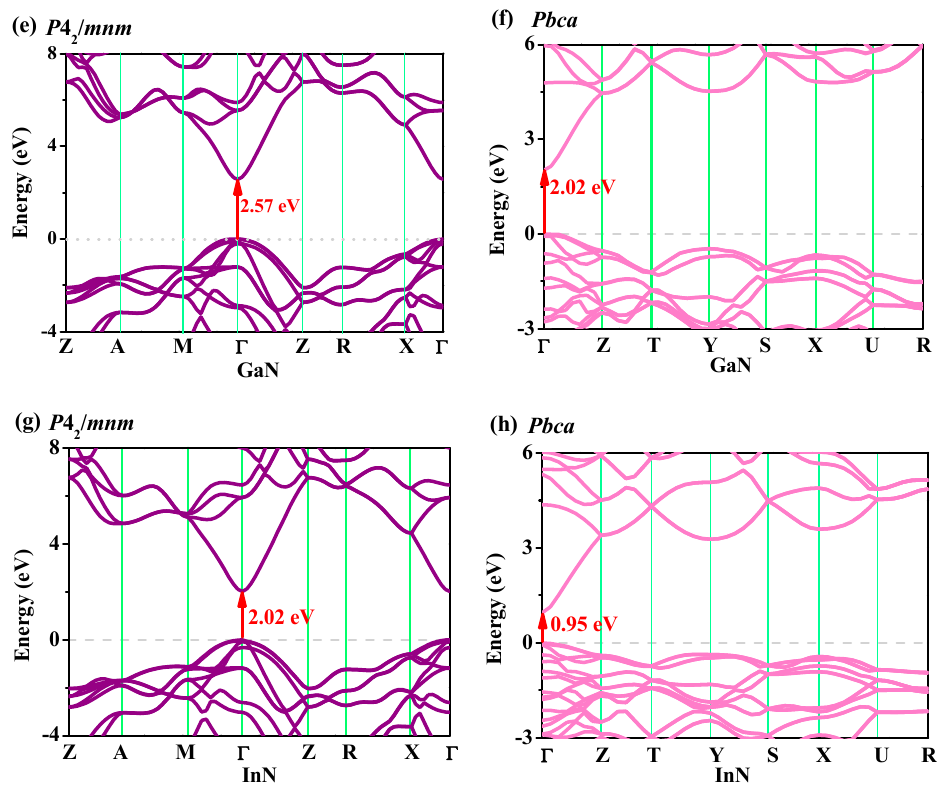
Figure 6. Electronic band structures for BN ( a ), AlN ( c ), GaN ( e ), and InN ( g ) in the P 4 2 / mnm phase; and electronic band structures for BN ( b ), AlN ( d ), GaN ( f ), and InN ( h ) in the Pbca phase.